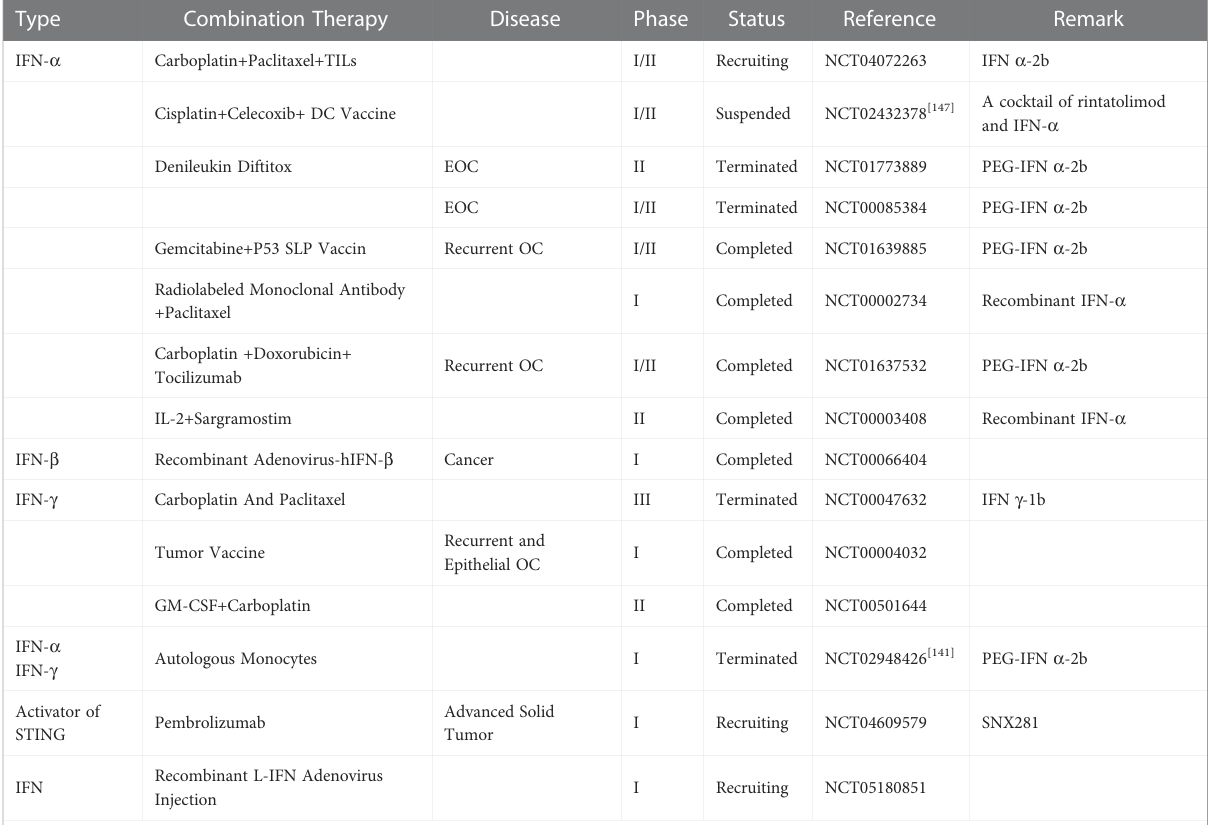
TABLE 1 The clinical trials based on IFN response in OC.